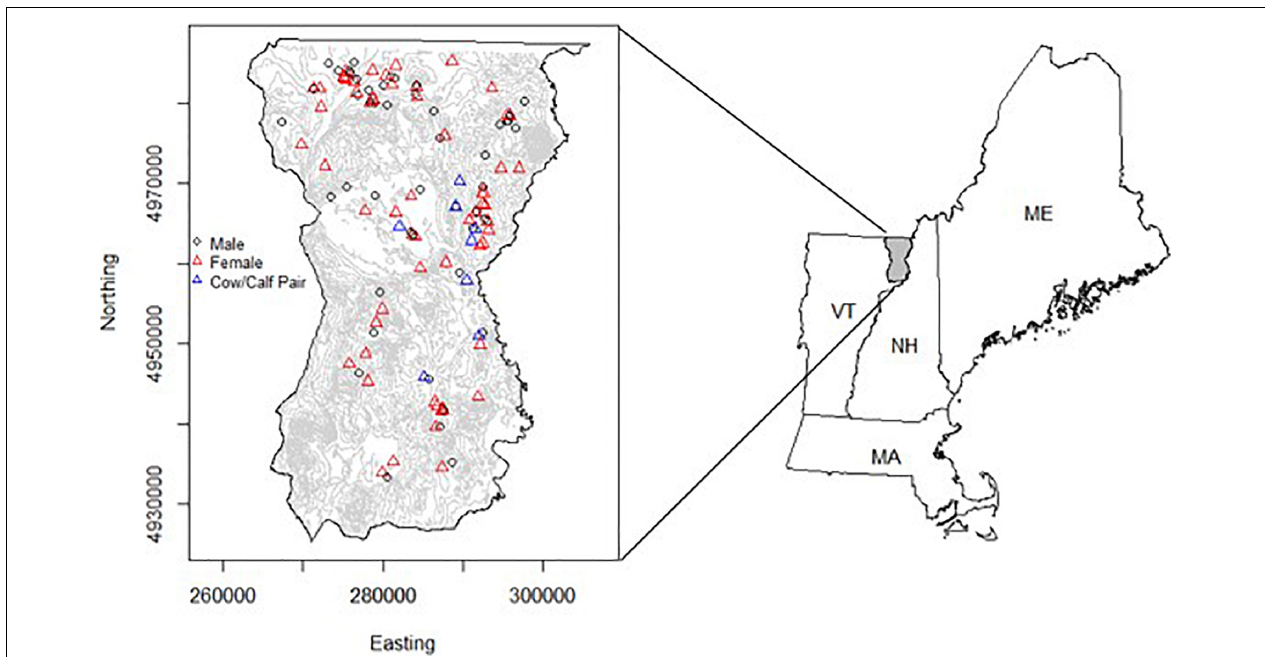
FIGURE 1 | The location of the study area in northeastern Vermont, United States (1,738 km 2 ), encompassing Essex County (Wildlife Management Unit E). GPS radio-collars were attached to moose ( Alces alces ) ( n = 126) in the area and monitored from 2017 to 2019. The study area was bounded by the Canada-U.S. border to the north, New Hampshire to the east, VT-Route 2 to the south, and VT-Route 114 to the west. Red triangles indicate the capture location for female moose ( n = 74), while circles indicate where male moose were captured ( n = 52). Blue triangles show the capture location for adult female moose ( n = 10) included in the habitat selection and fitness consequences analysis (i.e., objective 2). The map on the right shows the study area in relation to other northeastern states (ME, Maine; NH, New Hampshire; and MA,